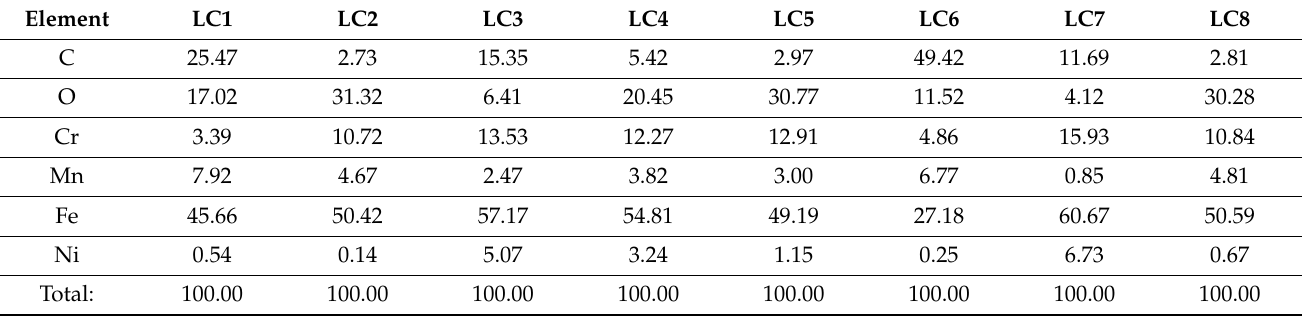
Table 2. Results of EDS analysis (wt%).